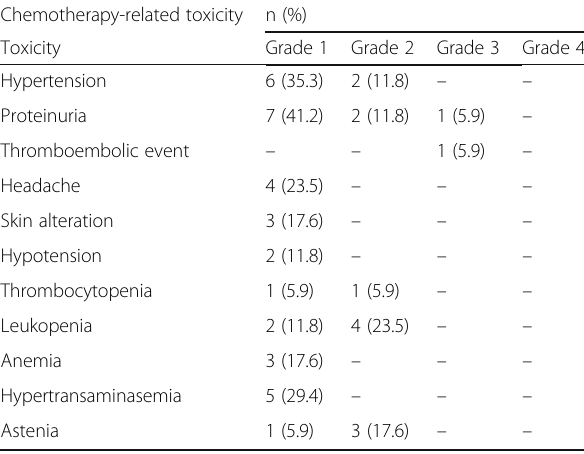
Table 3 Toxicities by grade of severity, according to the CTCAE (version